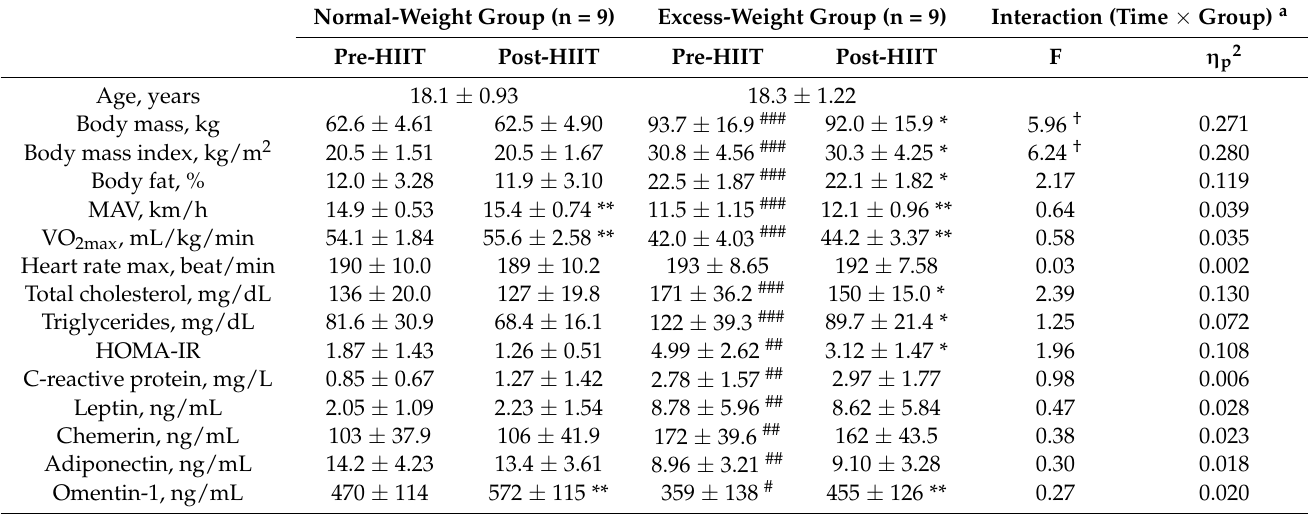
Table 1. Pre- and post-training values and interaction time × group for anthropometrical, physiologi- cal, and biochemical measures in normal-weight and excess-weight groups.